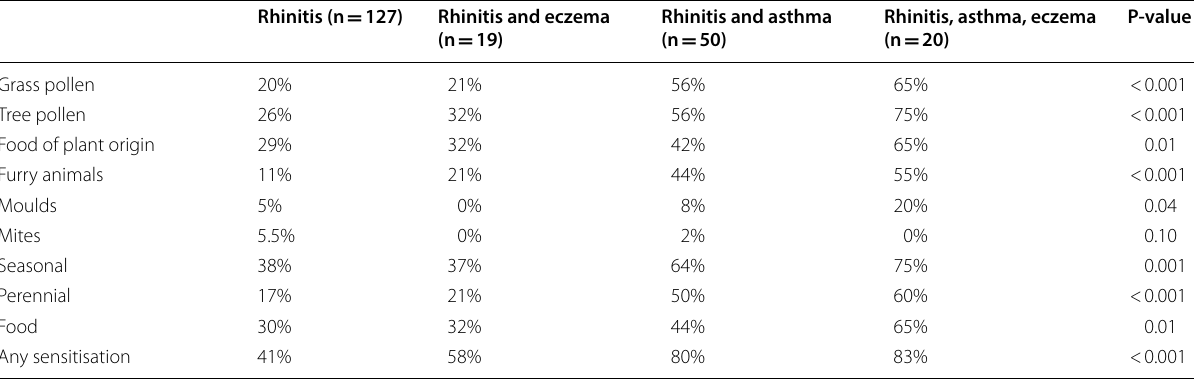
Table 3 IgE sensitisation in the participants